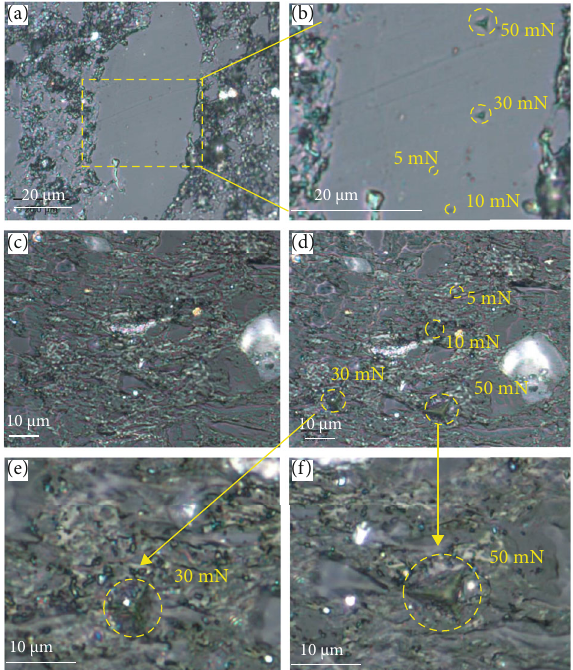
Figure 3: Photomicrographs of a quartz grain (a) before and (b) after nanoindentation tests, and clay minerals (c) before and (d – f) after nanoindentation tests.